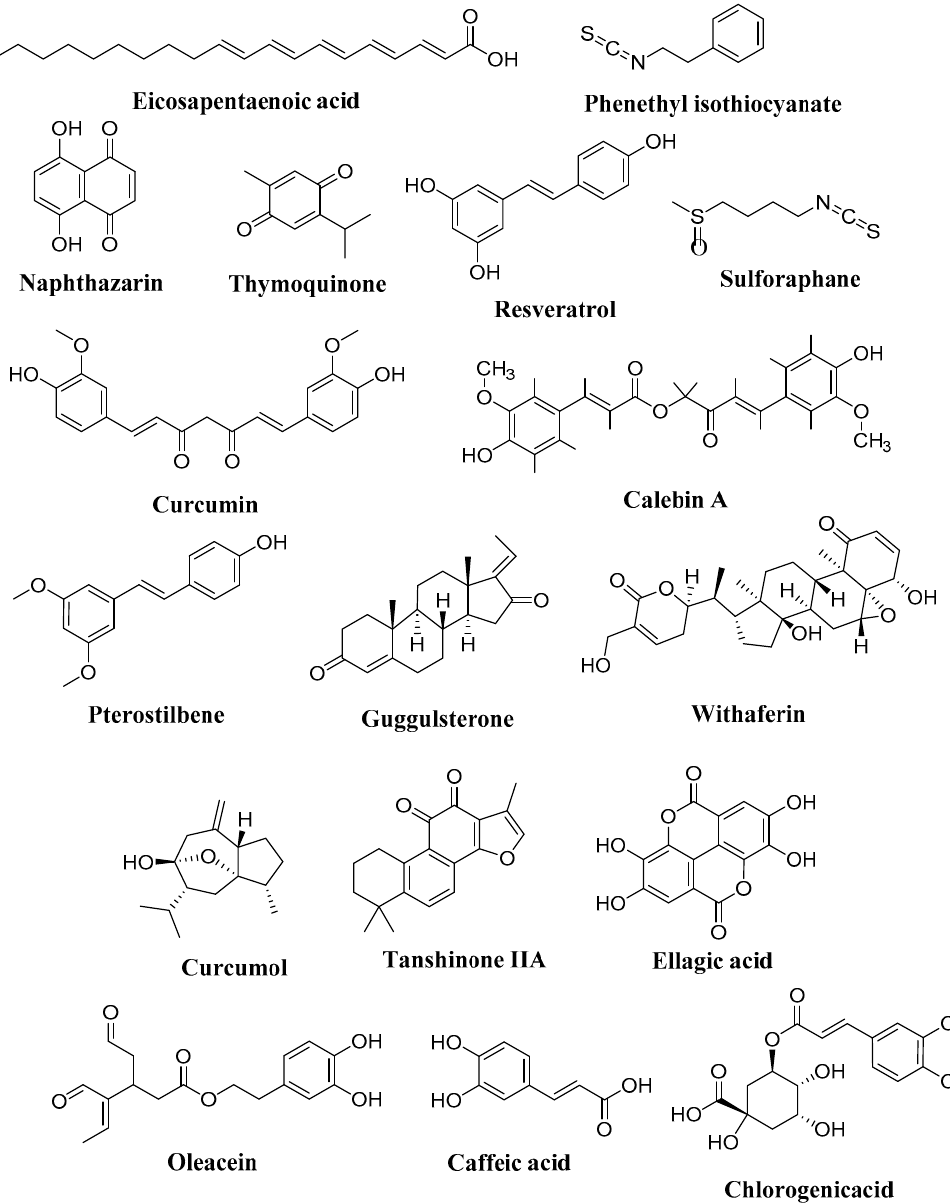
Figure 5. Chemical structures of different compounds associated with HDAC in human cancers.